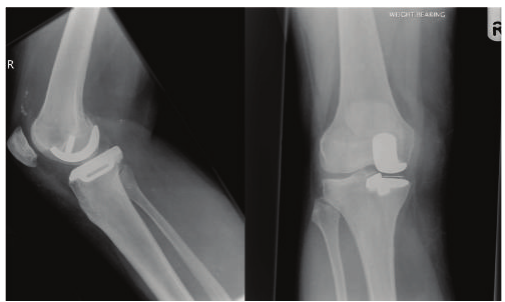
Figure 3: Lateral view and AP view radiograph of the knee taken following